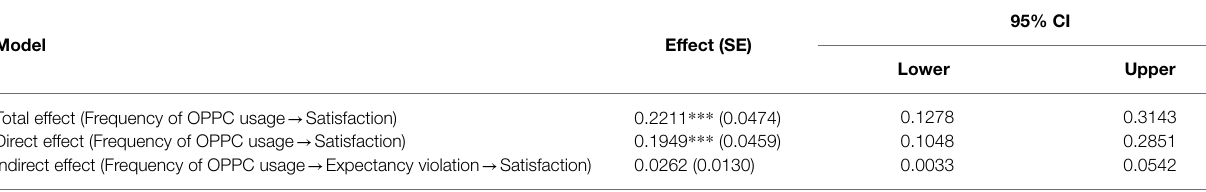
TABLE 4 | Mediating effect analysis